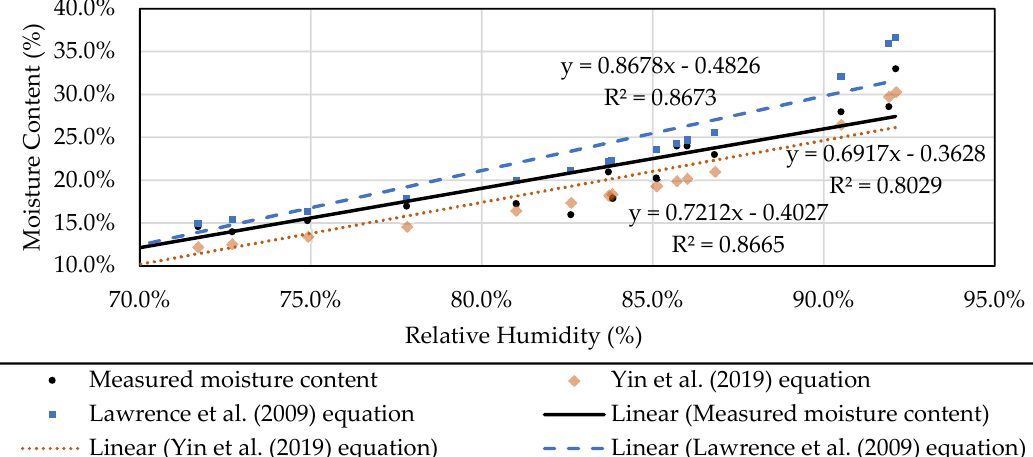
Figure 12. Comparison of calculated moisture content from isothermal model and actual moisture content in the experimental building.